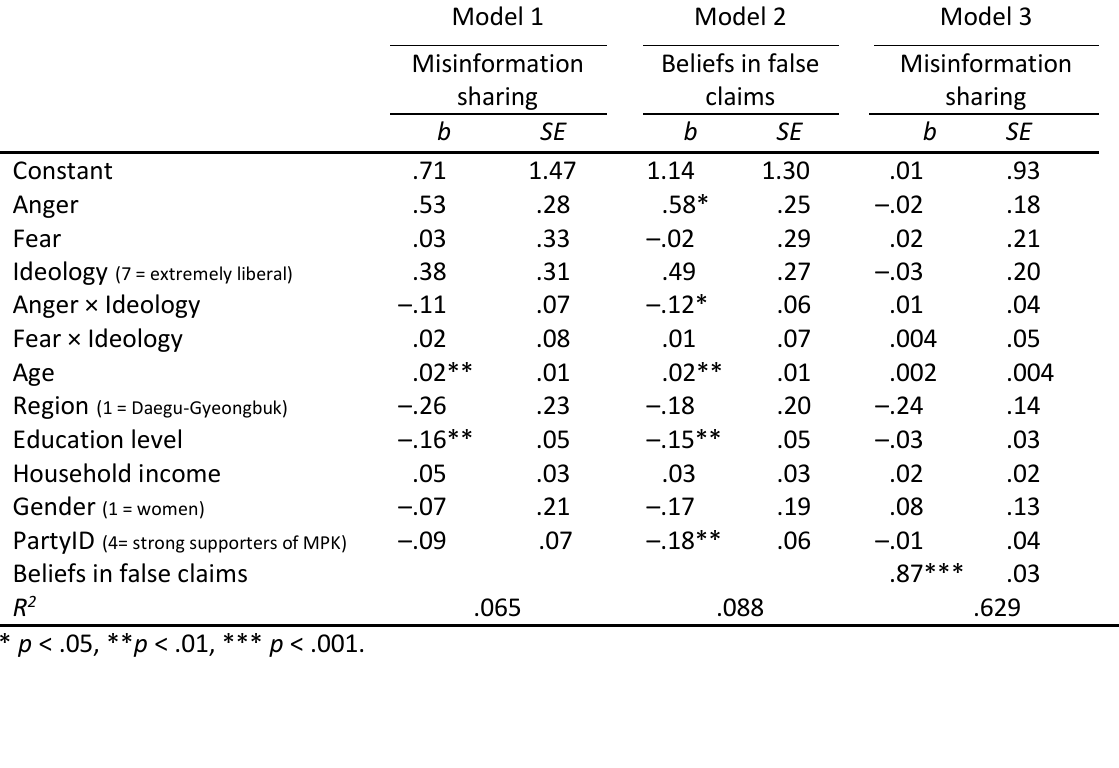
Table 1 . Regression results: The indirect effects of negative emotions and political ideology on misinformation sharing via beliefs in false claims about COVID-19 (N = 513).